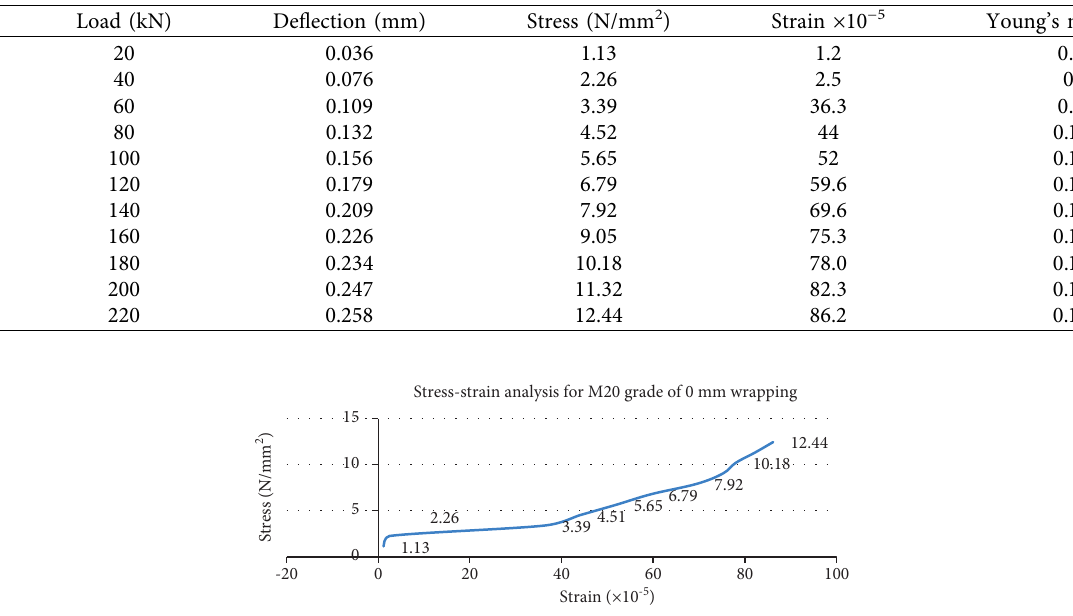
Figure 11: Stress-strain analysis for grade M20 with 0mm